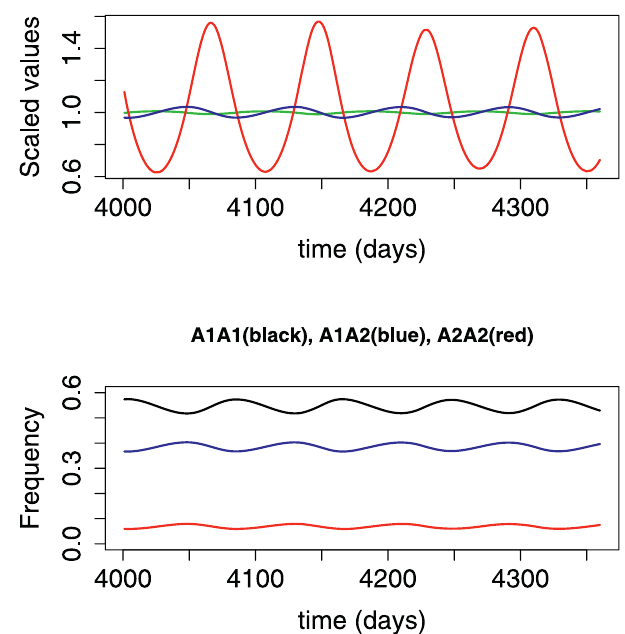
Figure 5. Numerical Solutions of the Chemostat Model with Diploid, Sexually Reproducing Prey Parameters for this were otherwise the same as in Figure 4, with the two prey homozygotes having the palatability and half-saturation values of the two prey clones in Figure 4. The prey heterozygote has the average of the homozygote half-saturation values, but the heterozygote palatability was closer to that of the palatable homozygote, p 12 ¼ 0.3 p 11 þ 0.7 p 22 . The upper panel shows (as in Figure 4) the total prey density (green), predator density (red), and mean prey palatability (blue), put into dimensionless units by scaling each variable relative to its temporal average over the time period plotted. The lower panel shows the frequencies of the three genotypes (black ¼ A 1 A 1 , blue ¼ A 1 A 2 , red ¼ A 2 A 2 ).